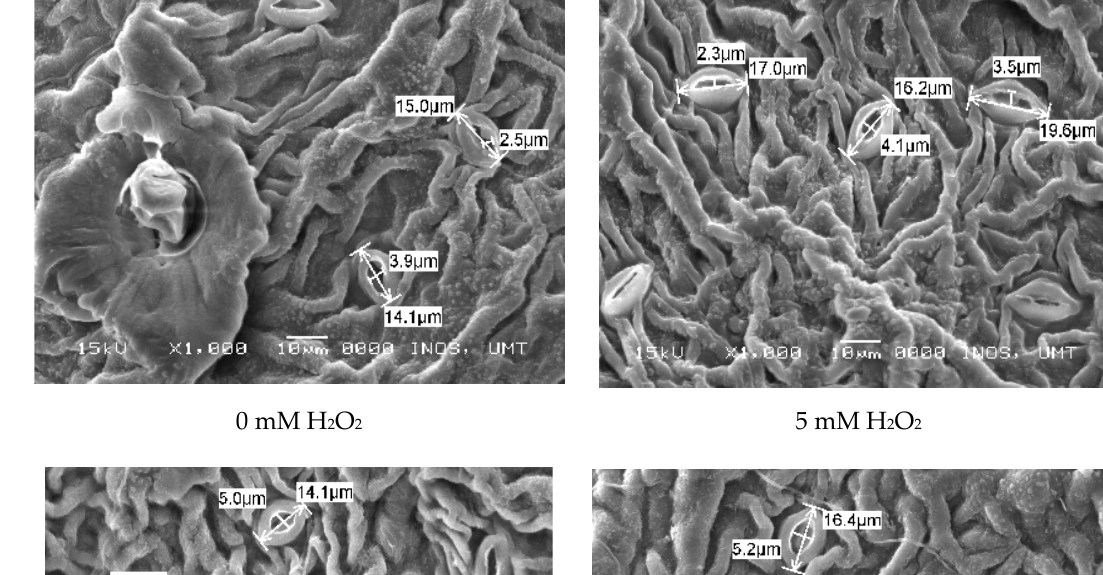
Figure 1. Scanning Electron Microscopy (SEM) photographs show single stomatal size of the H 2 O 2 -treated and untreated leaf of Ficus deltoidea var. deltoidea plant.